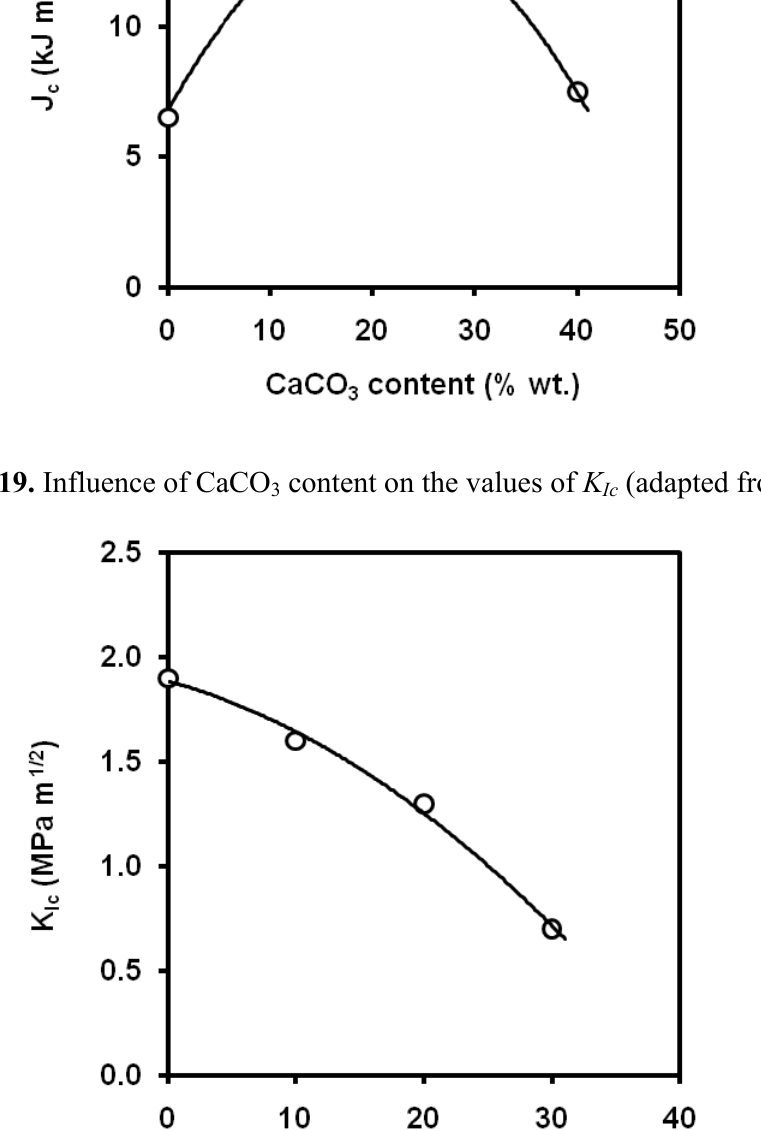
(adapted from [71]). c